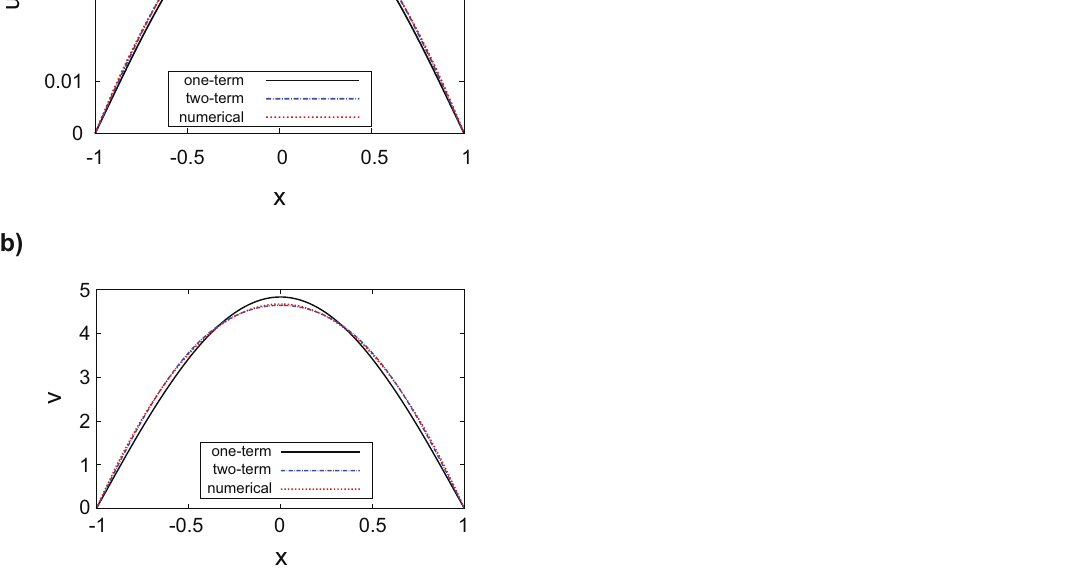
Figure 1: Steady state concentration pro fi les against x for ( a ) autocatalyst u and ( b ) reactant v , respectively. All parameter values were fi xed at λ 0.01